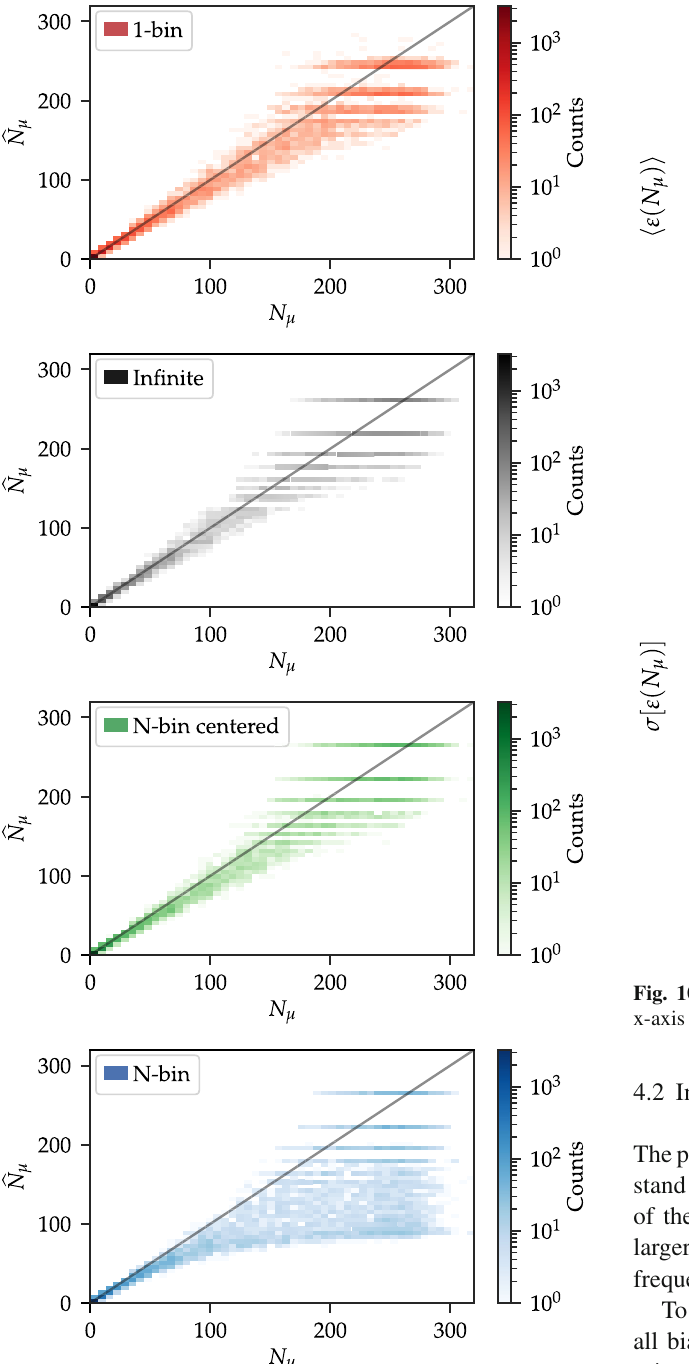
Fig. 9 Histograms of the estimated number of muons as a function of the input (true) number of muons for the four counting strategies considered: the 1-bin (top), the infinite window (second to top), the N- bin centered (second to bottom), and the N-bin (bottom). A grey solid line represents the identity. The detector-simulations set is the same as that of Fig. 7